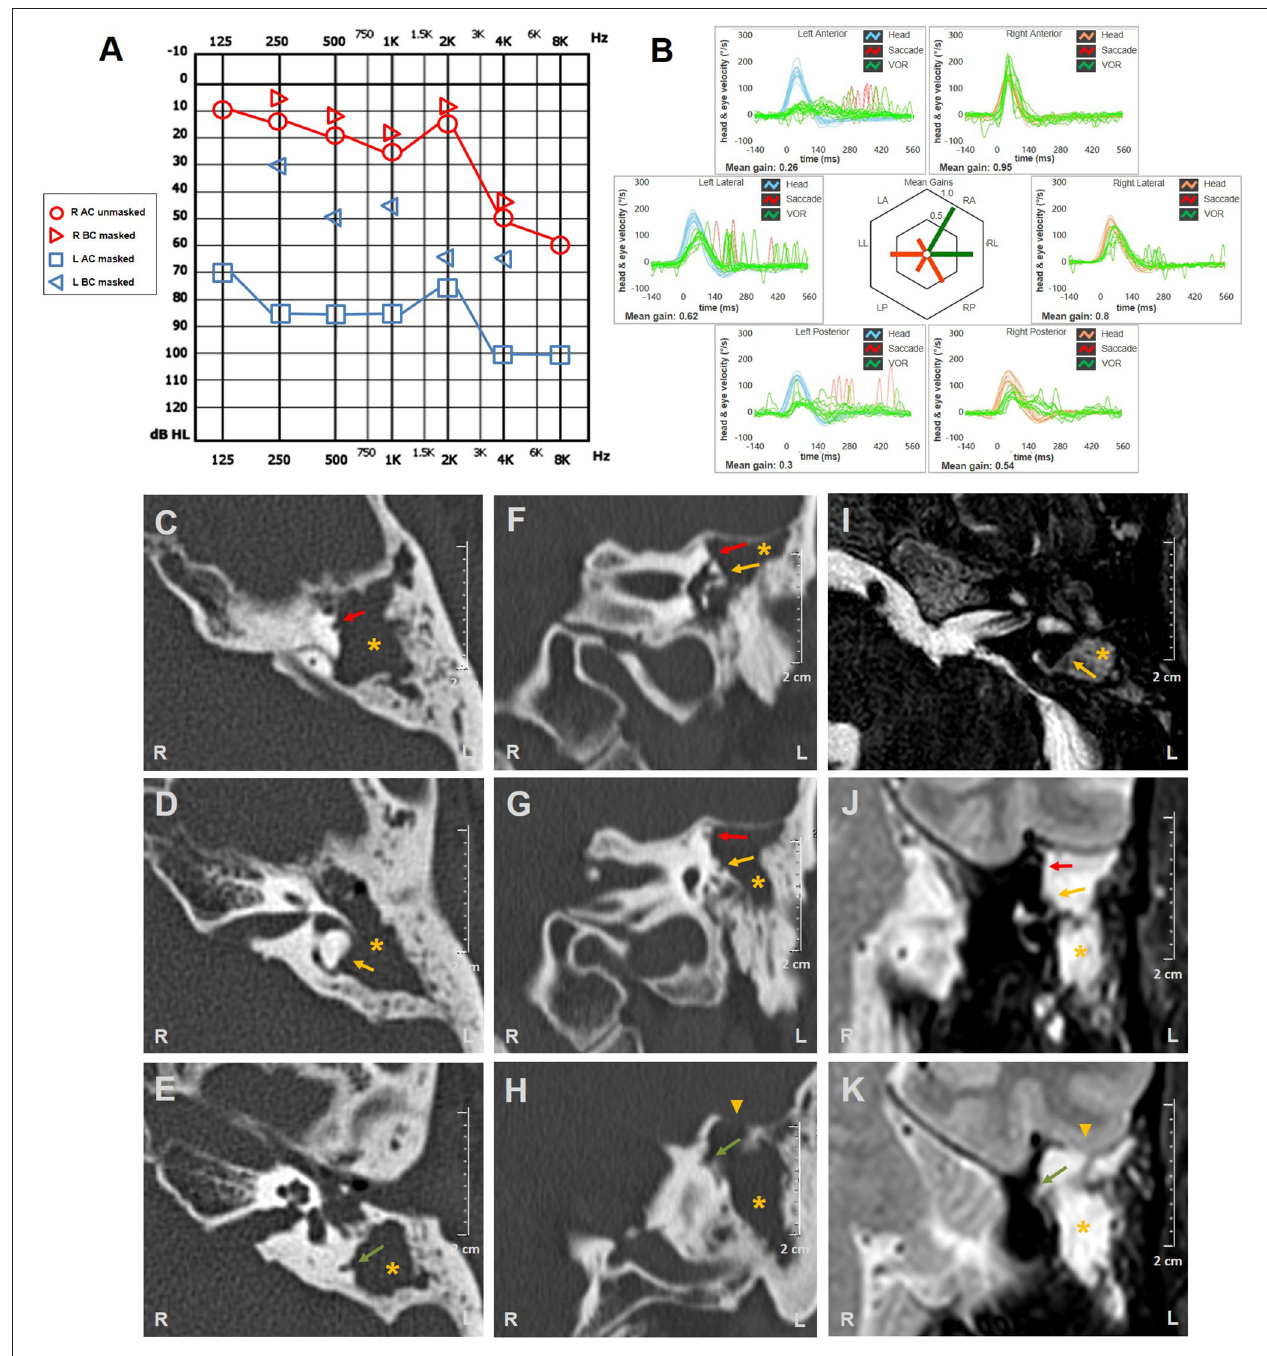
FIGURE 3 | Instrumental and radiological data of case three. (A) Audiometric testing showing high-frequency sensorineural HL on the right side and left mixed HL with significant ABG widened for low frequencies and mild-to-moderate down-sloping sensorineural hearing impairment. (B) vHIT detecting reduced VOR-gain values for all left SCs with overt saccades and slight hypofunction for contralateral PSC with no corrective saccades. Axial (C–E) and coronal (F–H) temporal bones CT scans completed with axial (I) and coronal (J,K) T2-weighted gadolinium-enhanced brain MRI showing soft tissue density ( yellow asterisks ) within left middle-ear and mastoid cavity eroding ossicles and tegmen tympani ( yellow arrowheads ). Bony labyrinthine erosions of left SSC ( red arrows ), HSC ( yellow arrows ), and PSC ( green arrows ) are highlighted. ABG, air-bone gap; AC, air conduction; BC, bone conduction; CT, computed tomography; HL, hearing loss; HSC, horizontal semicircular canal; L, left; LA, left anterior; LL, left lateral; LP, left posterior; MRI, magnetic resonance imaging; PSC, posterior semicircular canal; R, right; RA, right anterior; RL, right lateral; RP, right posterior; SC, semicircular canal; SSC, superior semicircular canal; vHIT, video head impulse test; VOR, vestibulo-ocular reflex.